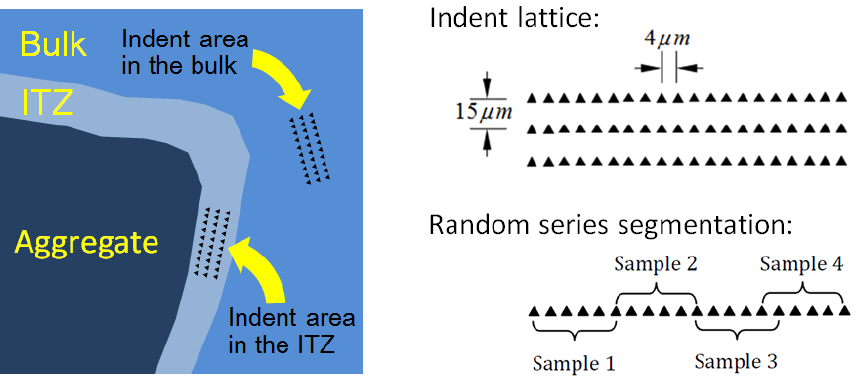
Figure 3. The schematic diagram for nanoindentation testing and the segmentation for the random